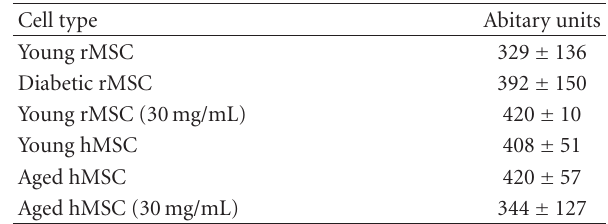
Table 1: Cell size grown on fibrin. Fibrin gels were made by mixing fibrinogen (3, 10, and 30 mg/mL) with thrombin (1 μ l/mL). Di ff erent MSC types were analysed for cell